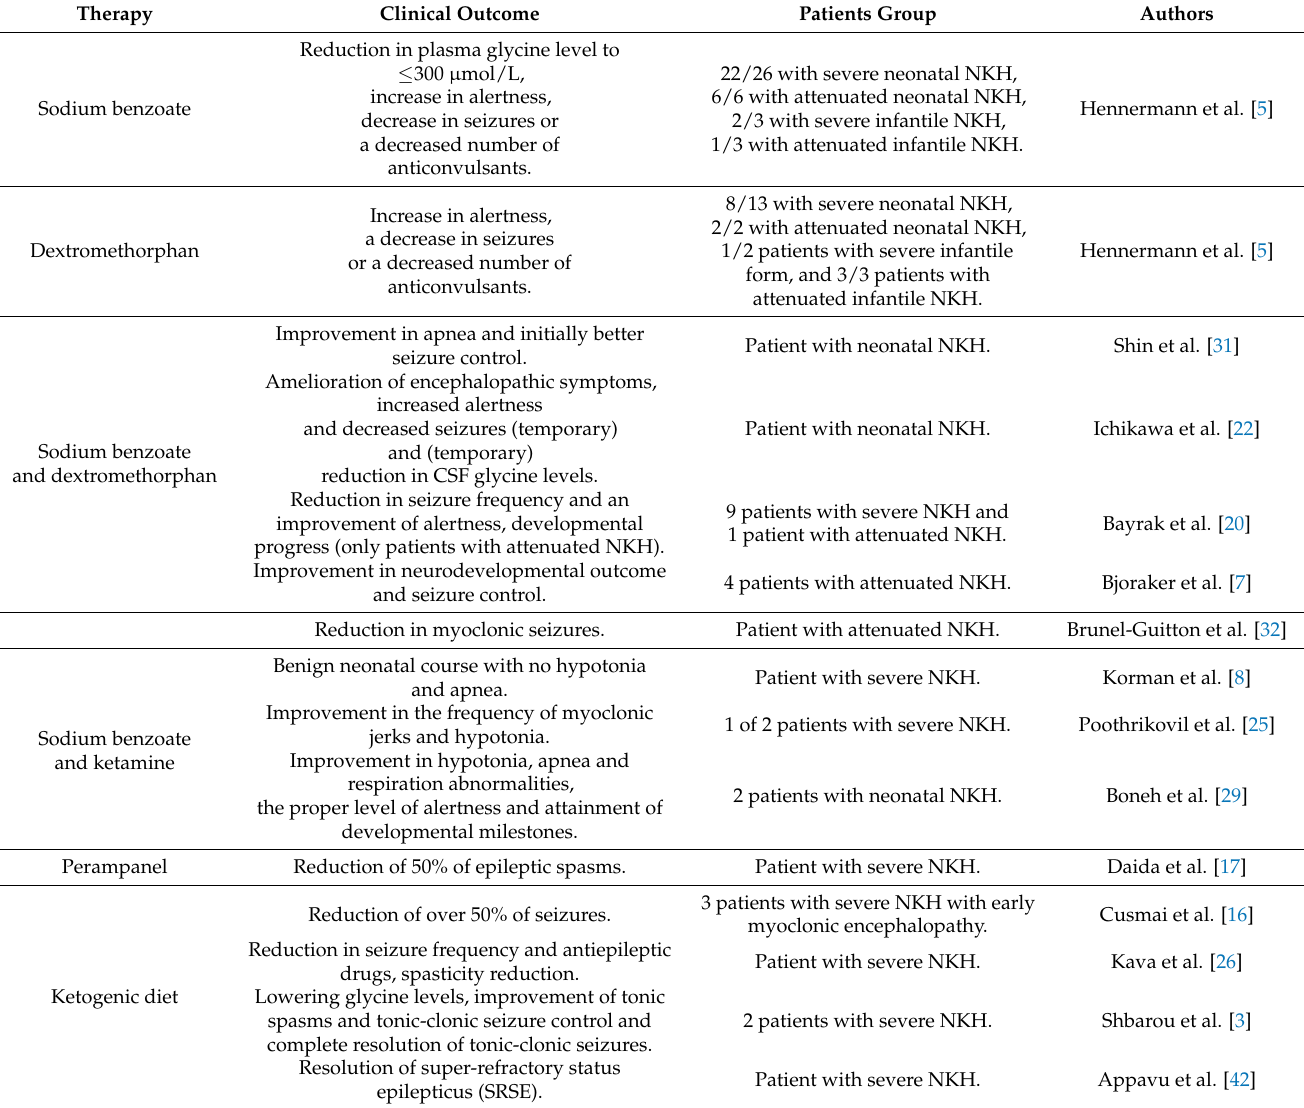
Table 1. Effectiveness of different therapies in